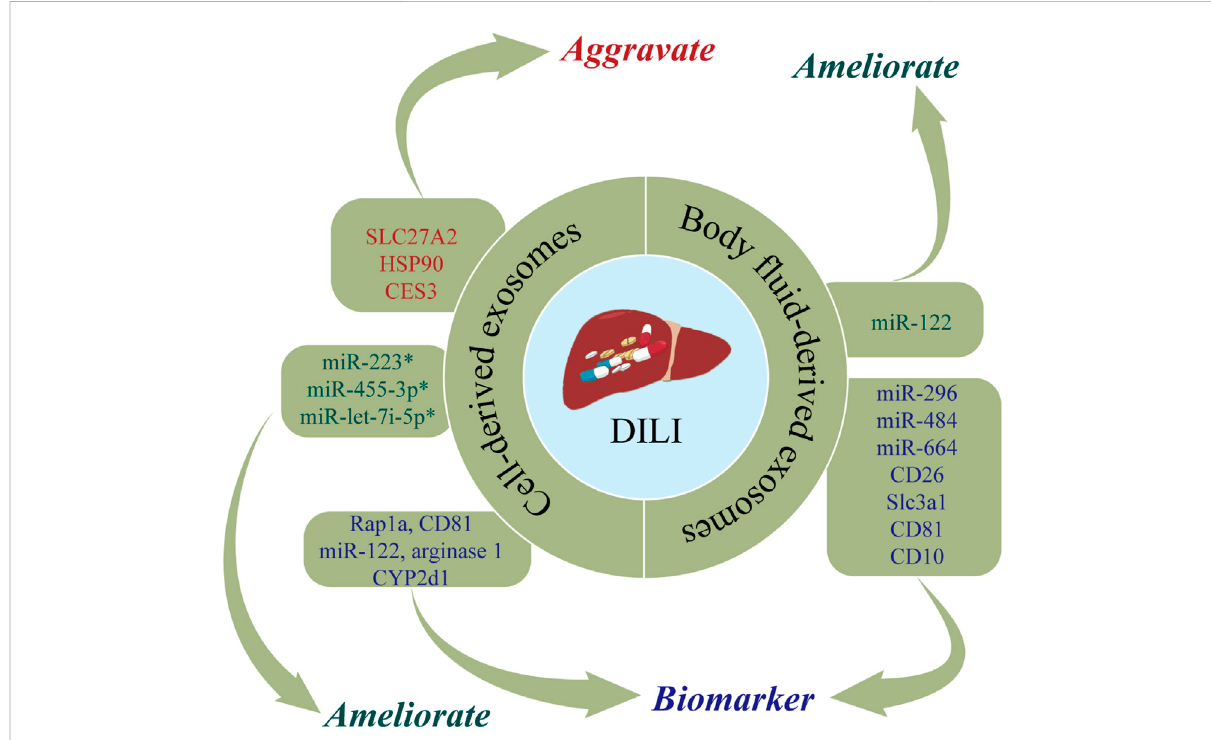
FIGURE 2 Therolesofnucleicacidsandproteinscarriedbyexosomesindrug-inducedliverinjury(DILI).NucleicacidsorproteinsthatmayaggravateDILI are highlighted in red, ameliorating DILI are highlighted in green, and biomarkers are highlighted in purple. * refers to nucleic acids and proteins carried by exosomes from mesenchymal stem